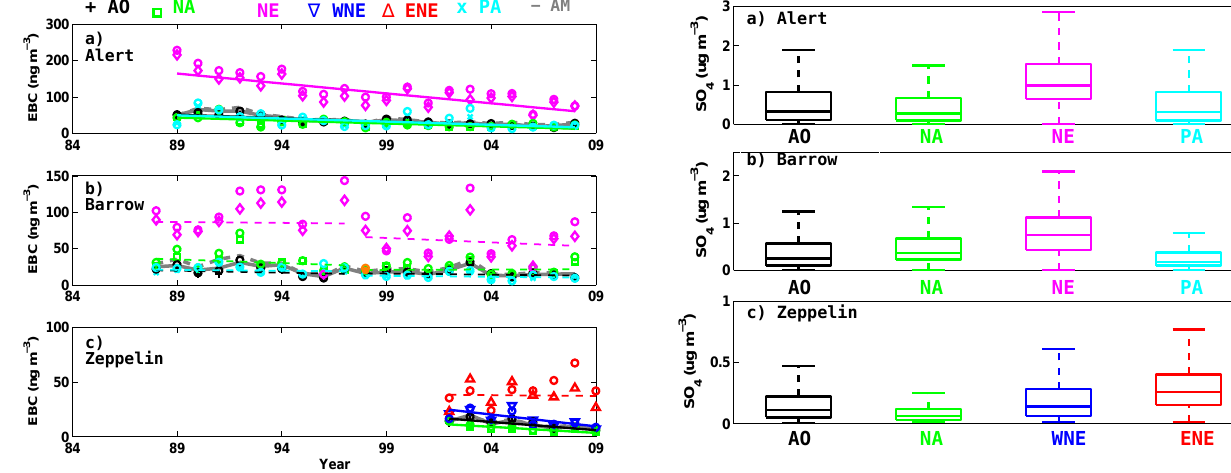
Fig. 13. Annual geometrical mean and median values of the EBC concentrations for all measurements (solid gray and dashed gray respectively) as well as associated to the four different clusters at Alert (a) , Barrow (b) , and Zeppelin (c) . Medians are marked with circles and geometric means with unique symbols according to the legend at the top. Trend lines calculated from the geometrical mean values are shown with solid lines for trends with a statistical sig- nificance on the 90% confidence level, other trends are shown with dashed lines. Due to change in instrumentation at Barrow, this data set was divided in the sub-periods 1988–1997 and 1998–2008 for which linear trends were calculated separately. The mean and me- dian values measured with the old instrument in 1998 are shown in orange.